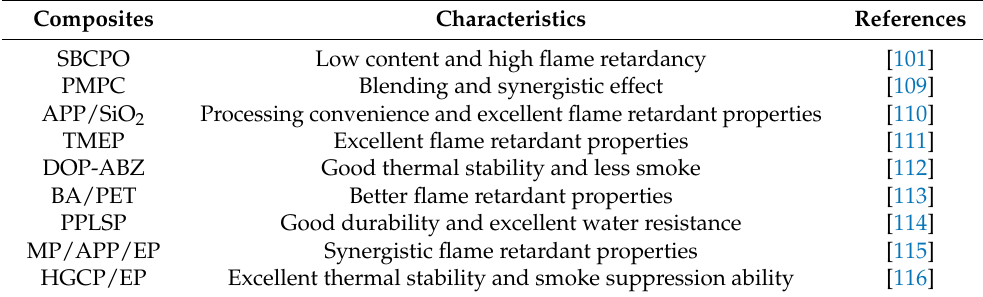
Table 3. Organic flame retardants and their characteristics.